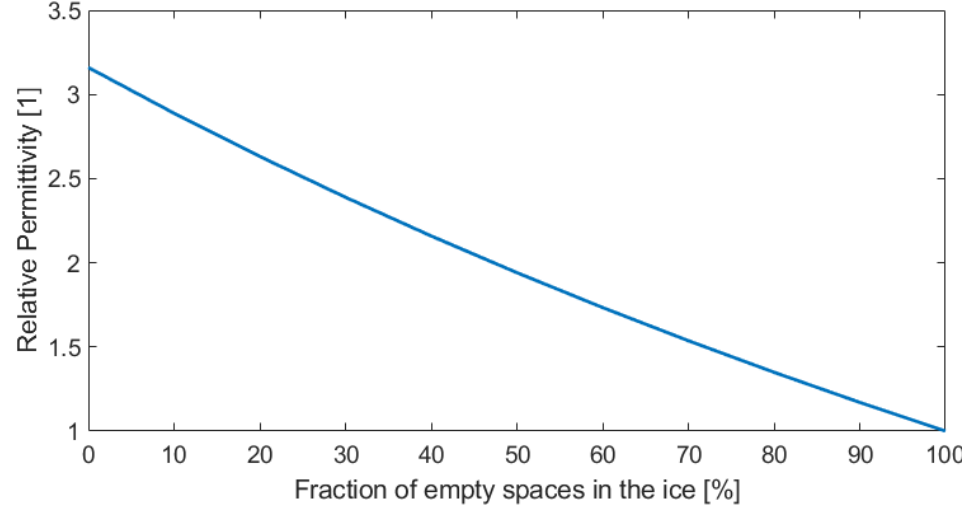
Figure 2. Permittivity behavior for empty inclusions in the